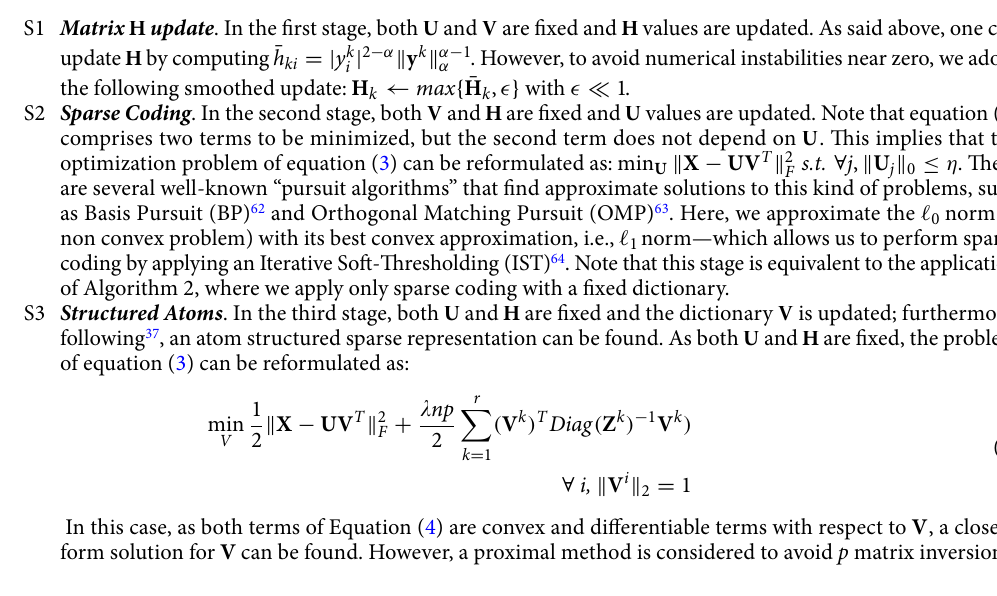
Algorithm 1 summarises the procedural steps of SRSSD , which comprises three stages: S1 Matrix H update . In the first stage, both U and V are fixed and H values are updated. As said above, one